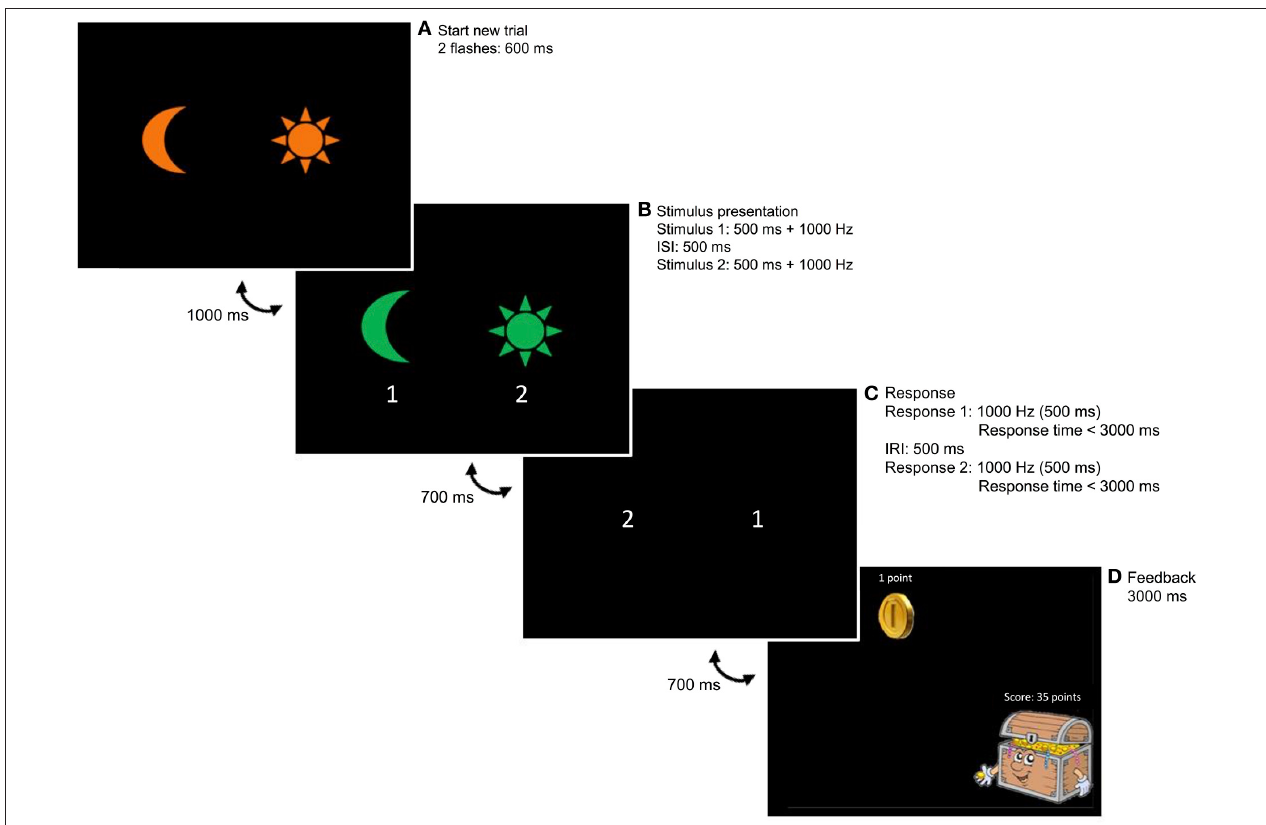
FIGURE 1 | Example trial of the learning task. (A) Two orange stimuli simultaneously flash twice, indicating the start of a new trial. (B) Two green stimuli appear. In this example, the moon appears first. When the moon has disappeared, the sun appears on the screen. (C) A first tone prompts a first response, followed by the second tone prompting a second response. Correct responding occurs when the stimulus sequence is reversed. In this example, a correct response is given when the participant presses the sun button (right) after the first prompt and the moon button (left) after the second prompt. (D) Upon responding correctly, CRF participants always received reinforcement; PRF participants received reinforcement on 60% of correct